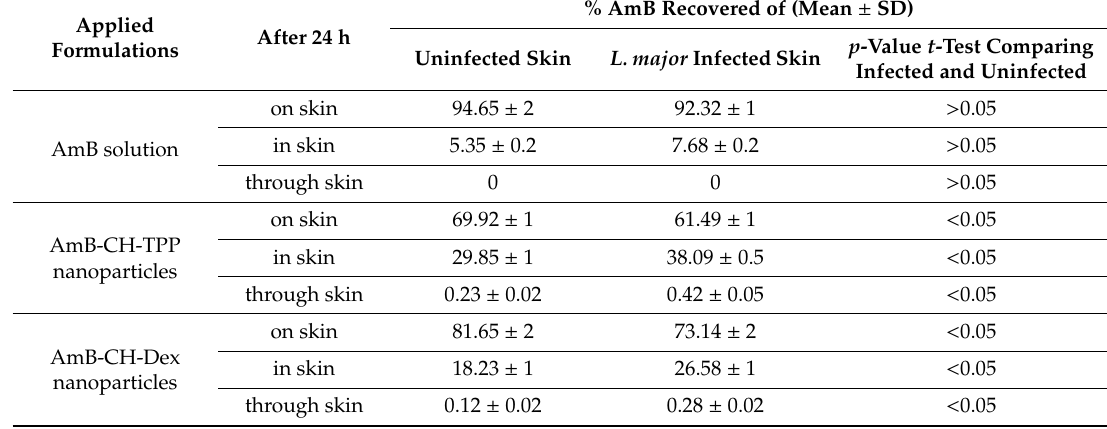
Table 7. Disposition of topically applied AmB from formulations following permeation experiment using healthy and L. major infected mouse